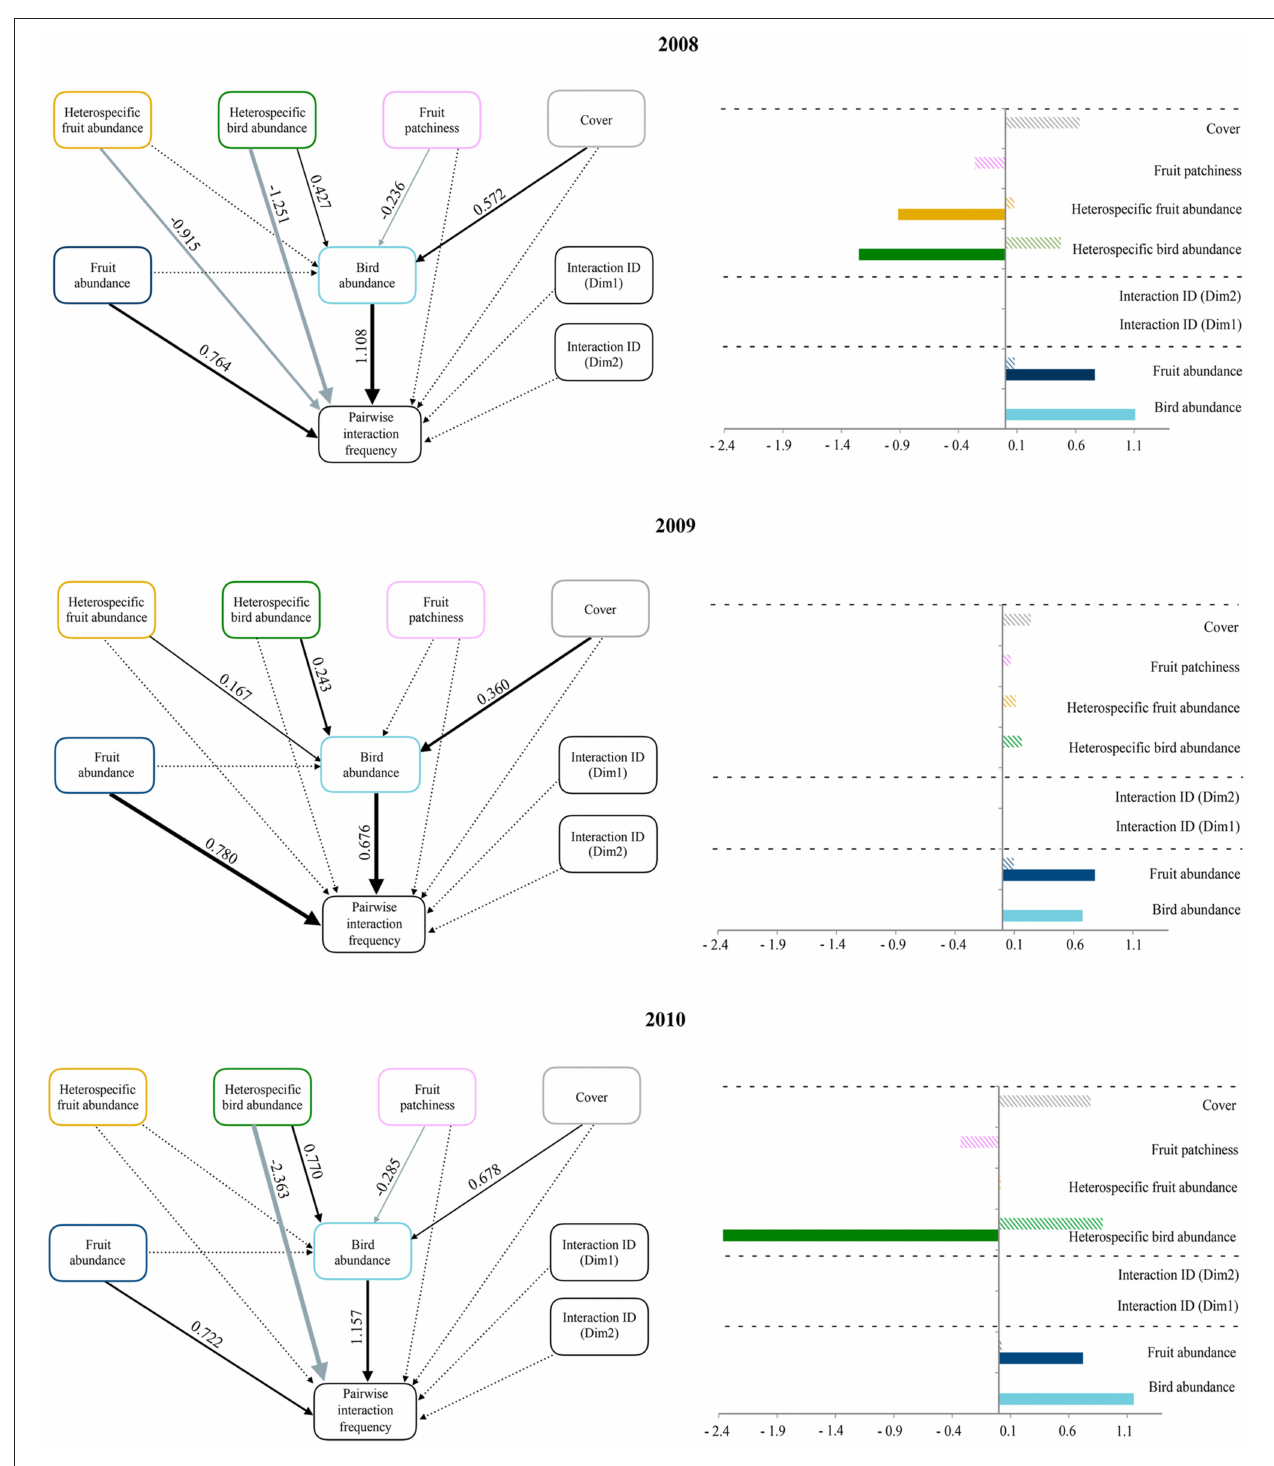
FIGURE 2 | Panels on the left illustrate path diagrams representing how ecological neighborhood influences the abundance of the interacting bird species and the pairwise interaction frequency (based on fruit consumption data) during 2008, 2009, and 2010. The effects of both interacting bird and fruit abundances and that of species identities (based on the two dimensions of a Correspondence Analysis on matrices of presence/absence of pairwise interactions across study blocks) on pairwise interaction frequency are also shown. Solid arrows represent statistically significant relationships ( p < 0.05); dashed lines are non-significant. Black and gray arrows represent positive and negative relationships, respectively. Values of standardized path coefficients are shown next to pathways for the significant relationships.